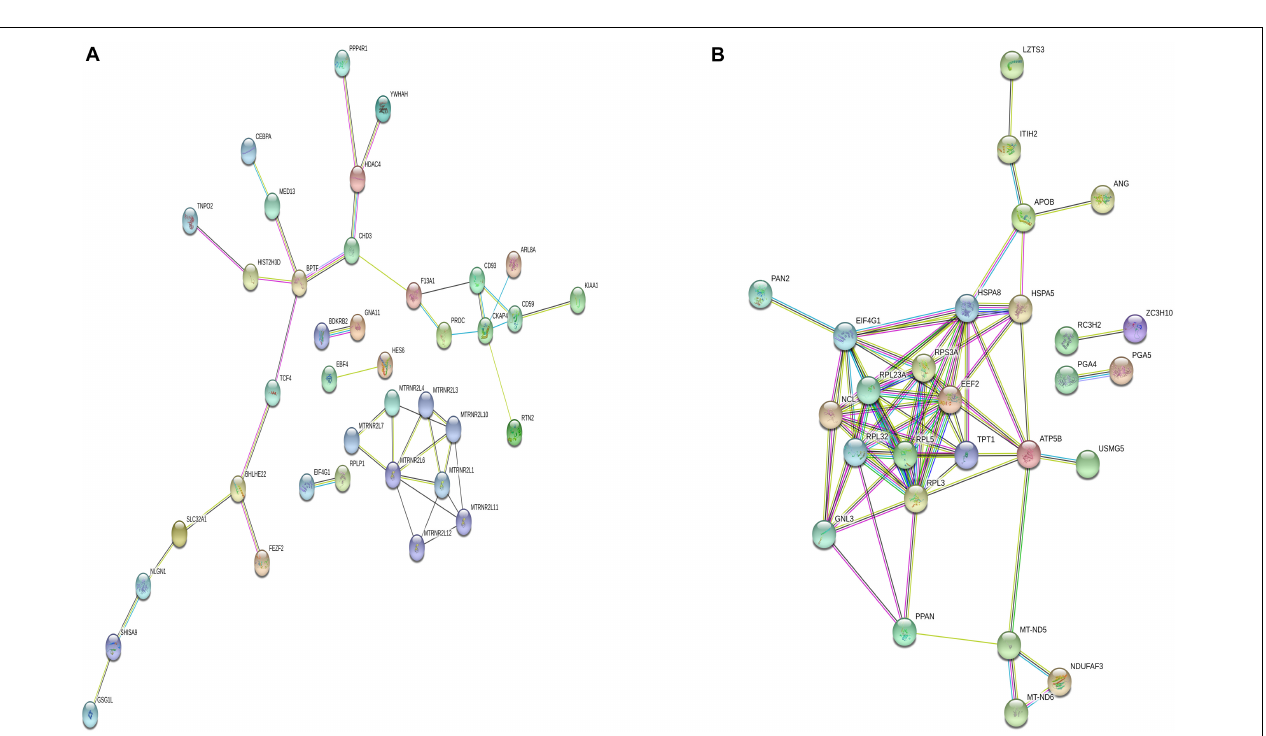
FIGURE 5 | GO terms of mRNAs with decreased m6A levels. (A) Cellular component, (B) biological process, (C) molecular function. The genes are mainly enriched in the ribonucleoprotein complex, extracellular region part, and cytosolic ribosome and are involved in a variety of molecular functions including poly(A) RNA binding, RNA binding, aspartic-type endopeptidase and peptidase activity, and biological progresses referred to nuclear-transcribed mRNA catabolic process, translational elongation, and mRNA catabolic process.